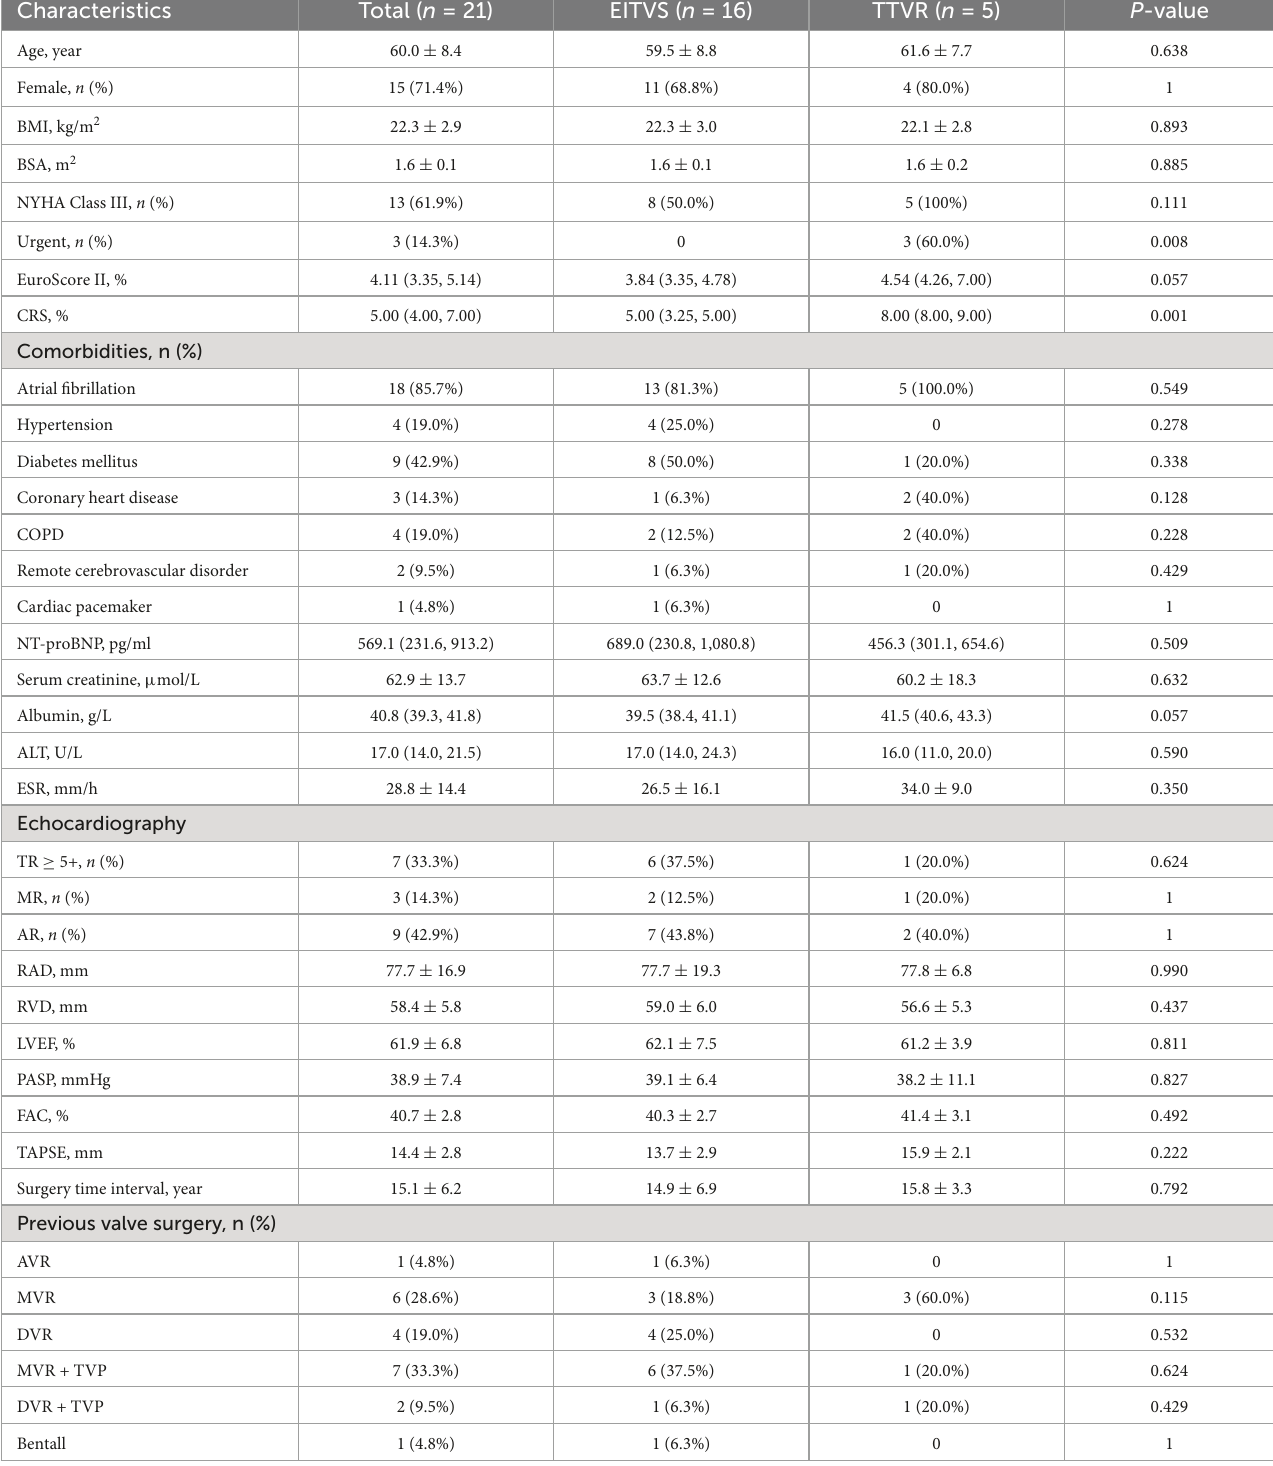
TABLE 1 Baseline